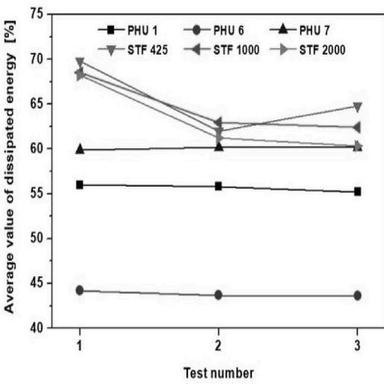
Stability of the energy dissipation capacity for poly(hydroxyurethane)s with different length of the oligoether chains – PHU1, PHU6, PHU7 and STFsilicone moulds.